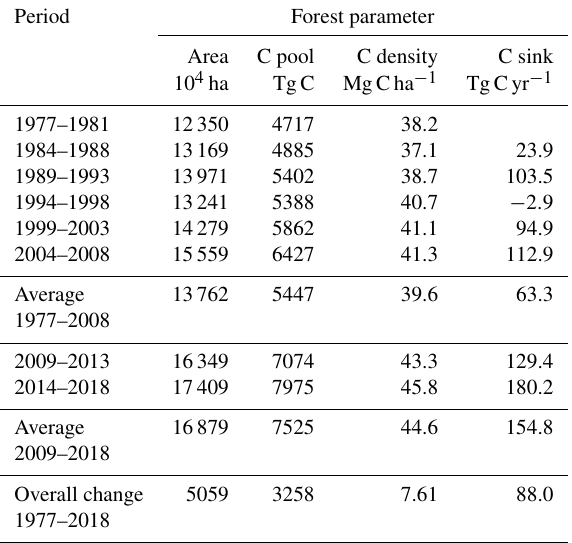
Table 1. Forest area, biomass C pool, C density, and C sinks from 1977 to